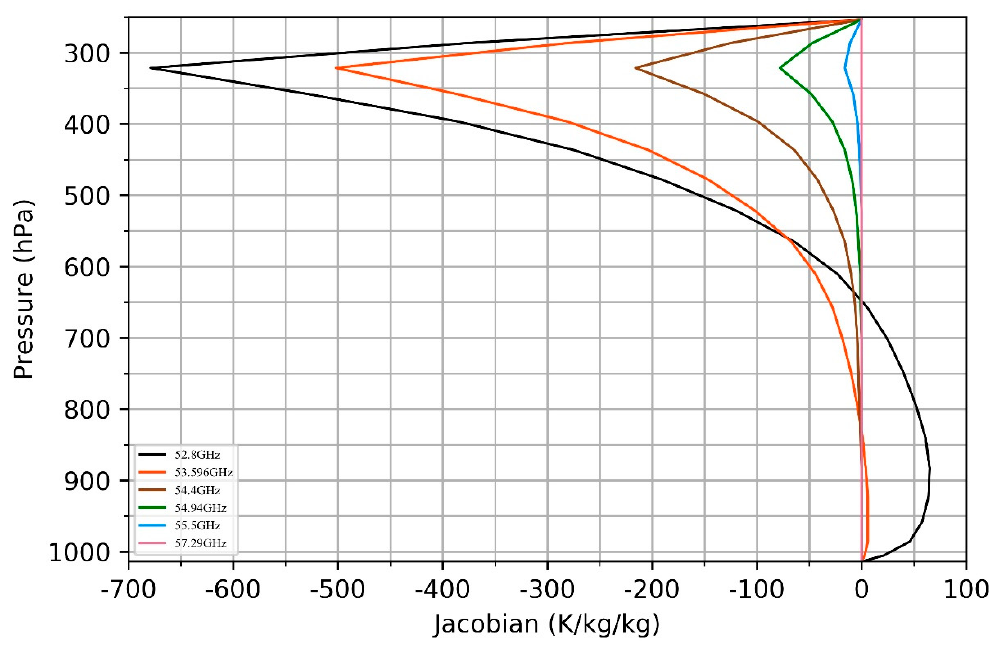
Figure 2. The cloud liquid water (CLW) Jacobians for the six channels shown in Figure 1. The CLW input was set to 0.0001 kg/kg in the layers from the surface to 322